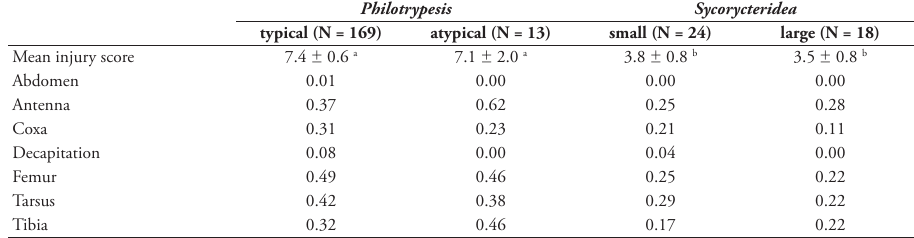
Table 4. Mean injury score per individual and injury proportion distributed among different body